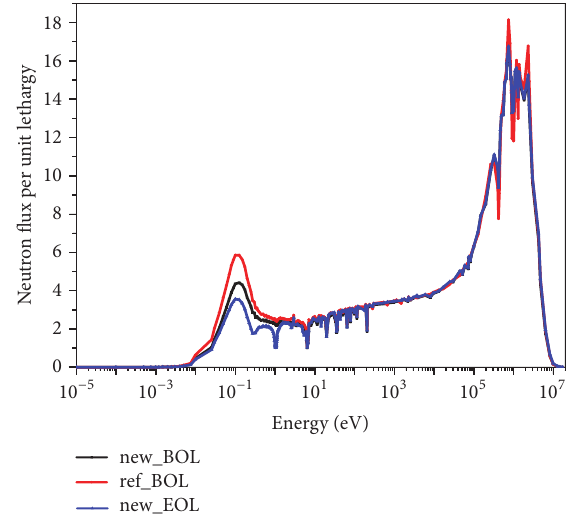
Figure 7: Spectrum of neutron